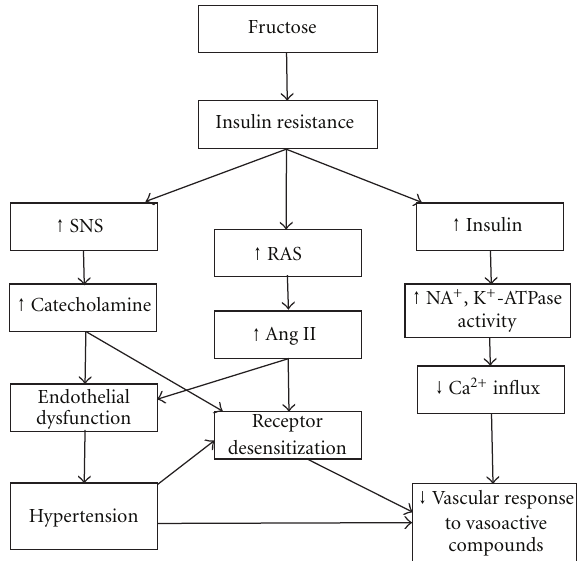
Figure 3: Proposed mechanisms that may explain the decreased vascular responses to vasoactive compounds in the fructose-fed rats. ↑ and ↓ stand for increase and decrease, respectively.